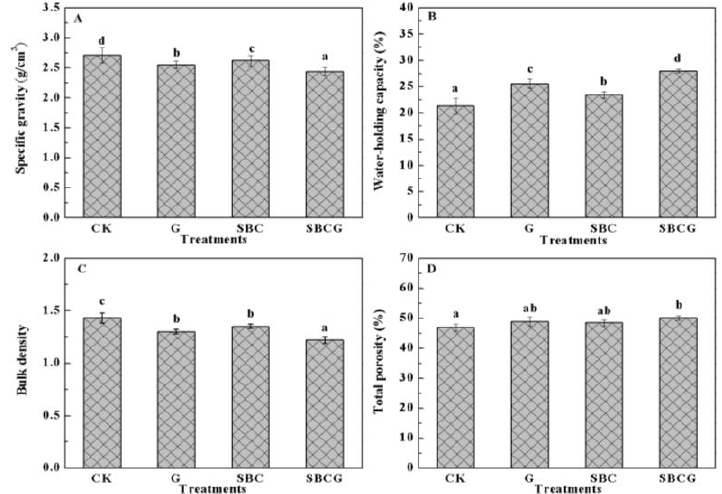
Figure 1. The physical properties (( A – D ) stand for specific gravity, water-holding capacity, bulk density, total porosity, respectively) of ion-adsorption clay (IAC) mining wasteland soil in the un-amended control (CK), alfalfa revegetation (G), sludge biochar amendment (SBC) and combined amendment (SBCG) treatments. Different characters, a, b, c, and d, were used to indicate significant differences at p < 0.05. Vertical bars indicate standard deviation.